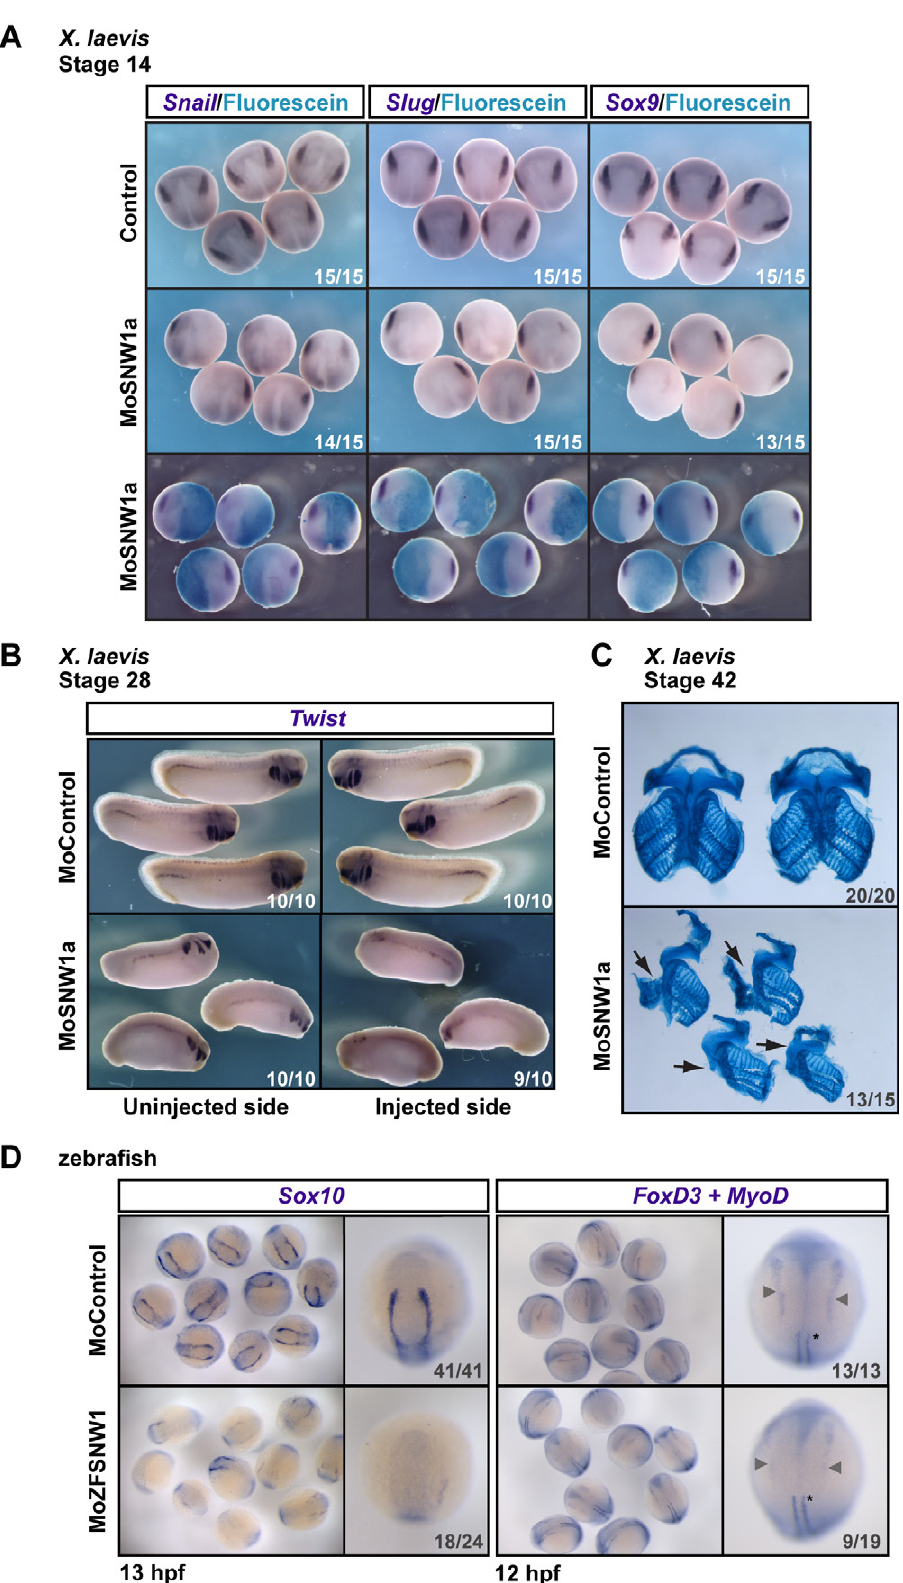
Figure 2. SNW1 knockdown inhibits neural crest induction. (A) Injection of MoSNW1a (Figure S3) results in the loss of neural crest markers Snail, Slug , and Sox9 on the injected side at stage 14. MoSNW1a (20 ng) was co-injected with Fdx as a tracer in one cell of a two-cell Xenopus embryo. The tracer was detected using an anti-fluorescein antibody. Control embryos were uninjected. (B) Two-cell Xenopus embryos were injected in one cell